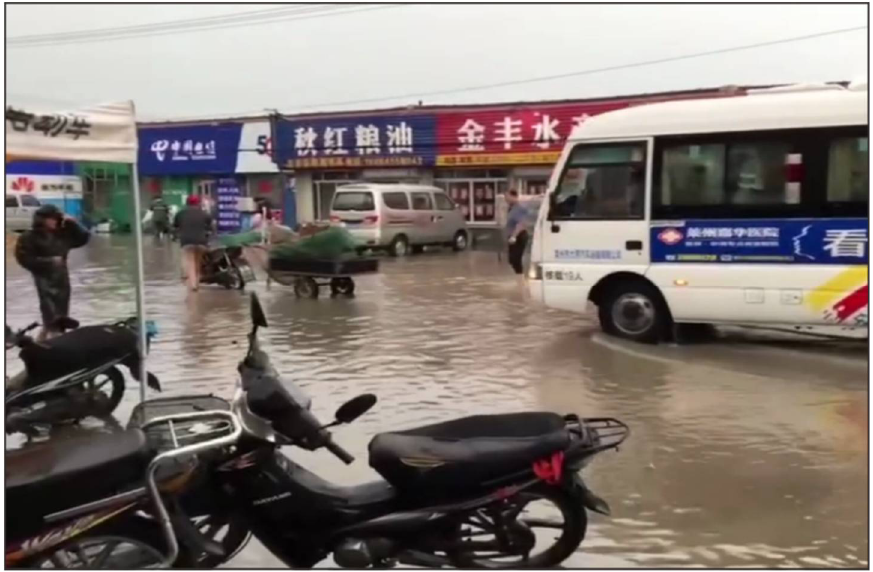
Figure 10. The severe subsidence area during rainy days.